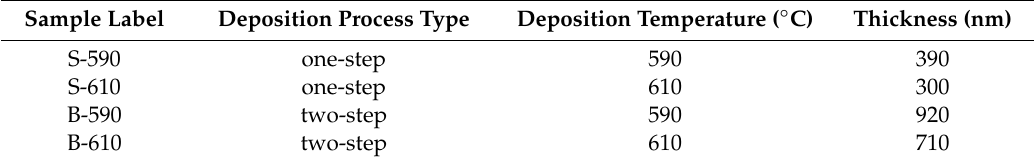
Table 1. Parameters for SnO 2 thin film samples: sample labels, deposition process type, deposition temperature and layer